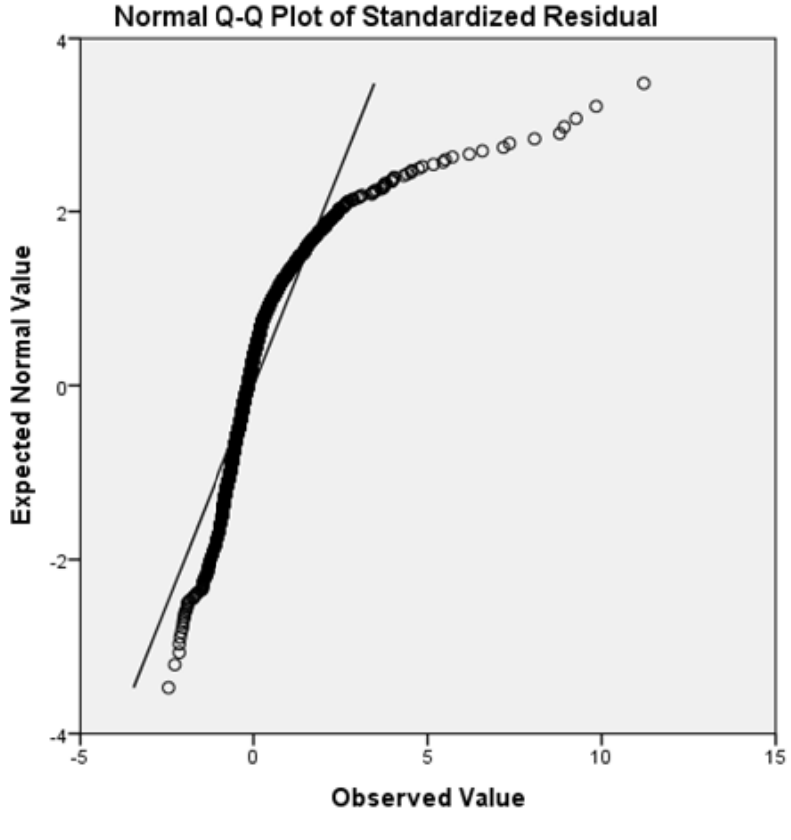
Figure 3. Q–Q Figure 3. Q – Q plot.